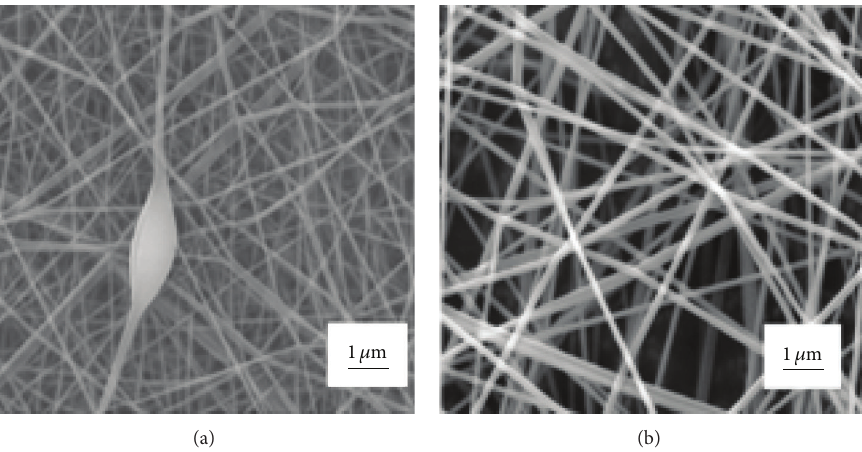
Figure 4: SEM images of P(AN-VAc-PMMT) ((a) 0%, (b) 2%) electrospinning fibers processed in a capillary tube with an inner diameter of 0.7 mm at a voltage of 30 KV, a spinning distance of 25 cm, and a speed of 0.5 mL/h.